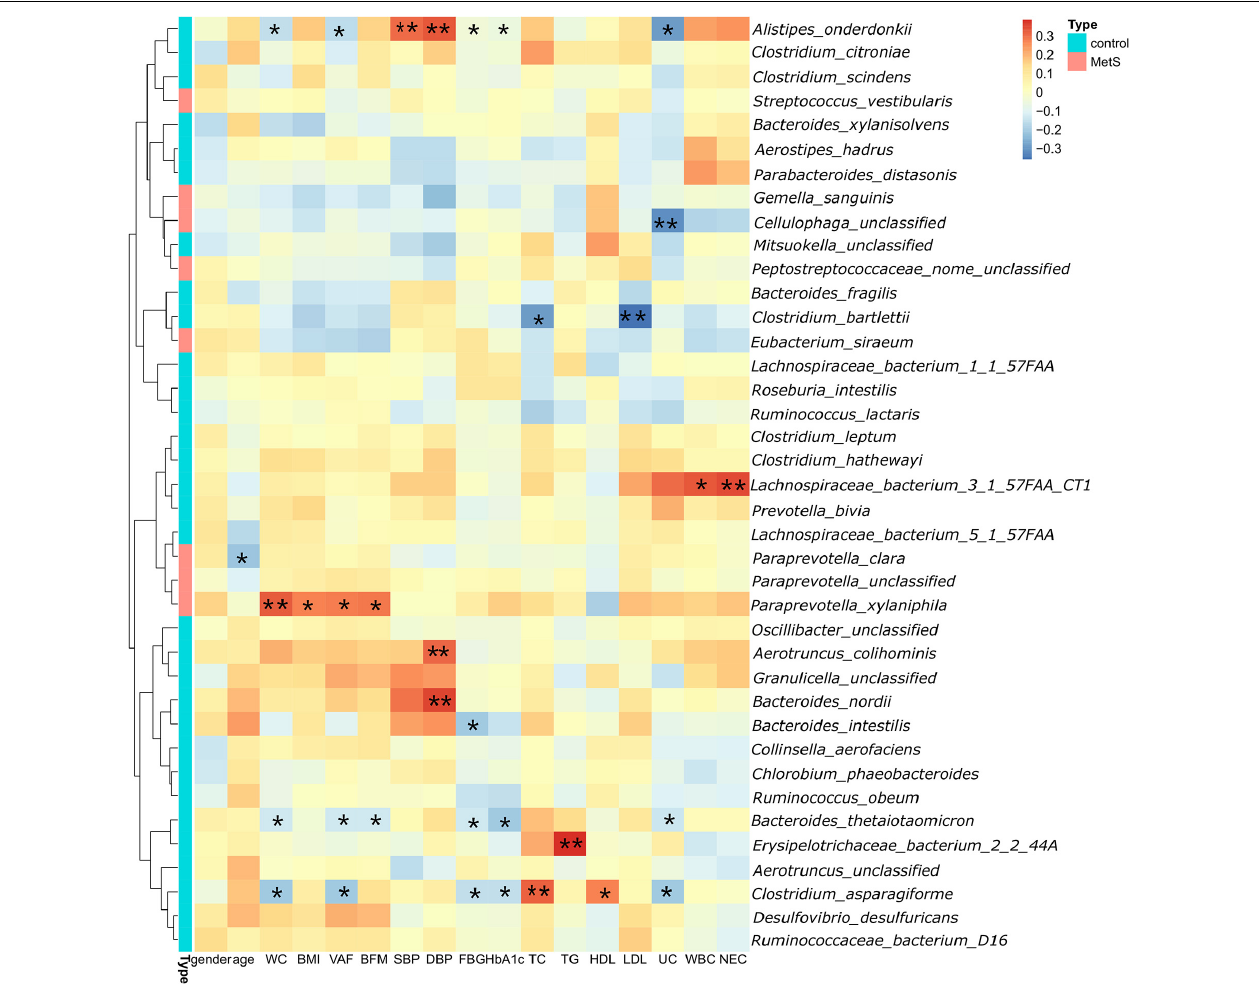
FIGURE 4 | Significant correlations between bacteria and clinical characteristics. We found 28 species in which the abundance was negatively correlated with WC. Three species ( Alistipes onderdonkii , Bacteroides thetaiotaomicron , and Clostridium asparagiforme ) were negatively correlated with WC, VFA, FBG, HbA1c, and UC.* p < 0.05, ** p <